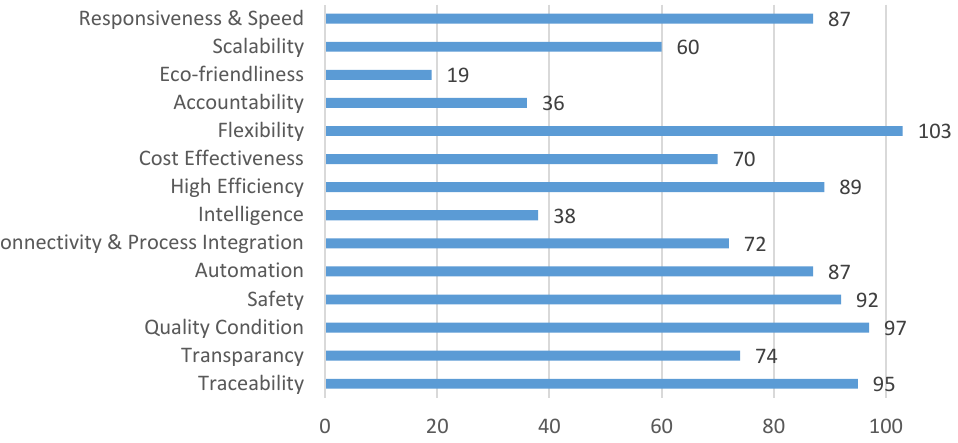
Figure 6. Characteristics of integrating technologies to improve the perishable food supply chain.